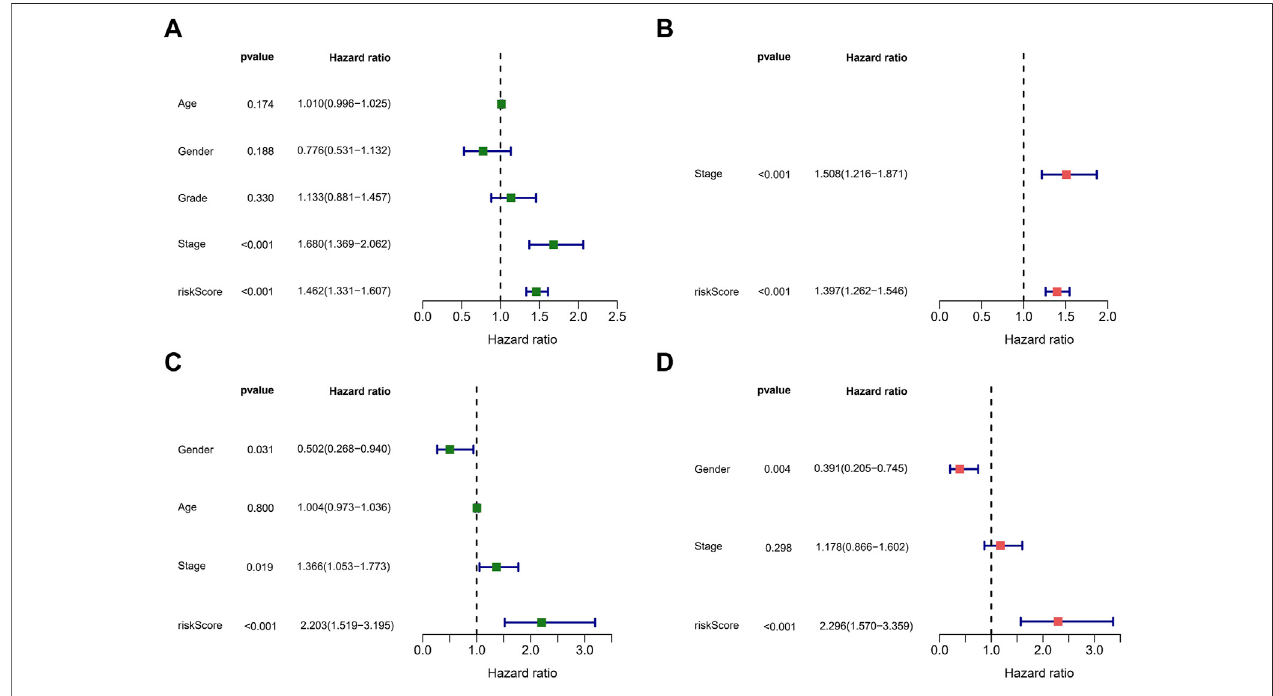
FIGURE 6 | Assessment of the prognostic signature. (A,C) Univariate analysis of risk score and clinical characters in the TCGA (A) and ICGC (C) cohorts. (B,D) Multivariate analysis of risk score and clinical characters in the TCGA (B) and ICGC (D) cohorts.